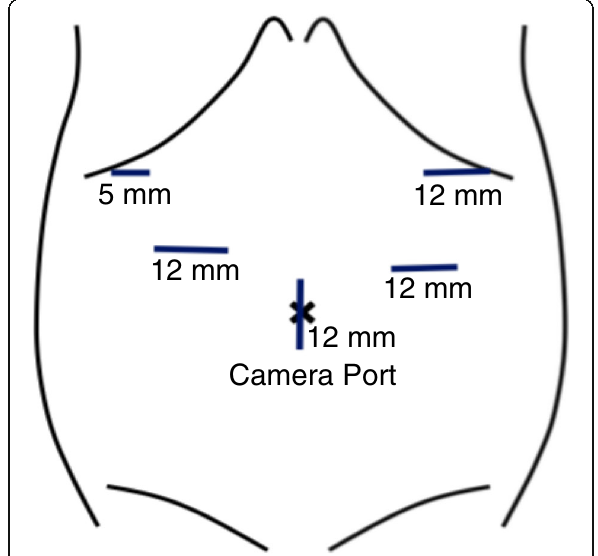
Fig. 1 The placement of surgical